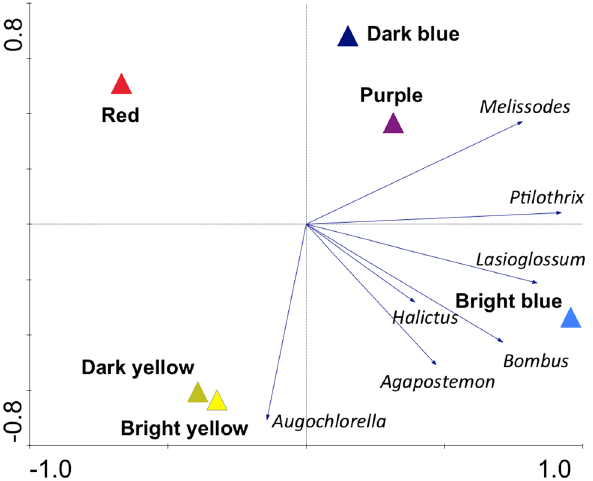
Figure 4. Ordination (redundancy analysis; RDA) biplot showing the association of bee genera and different colored vanes.